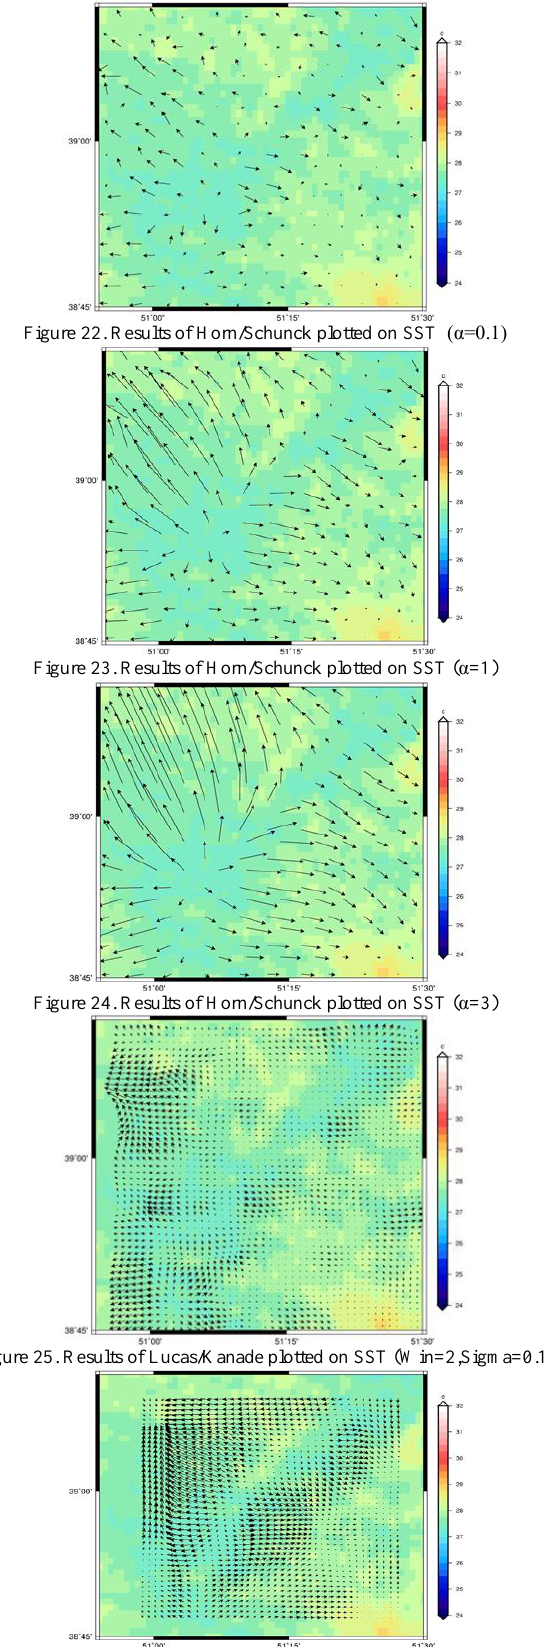
Figure 26. Results of Lucas/Kanade plotted on SST (Win=5, Sigma=1)